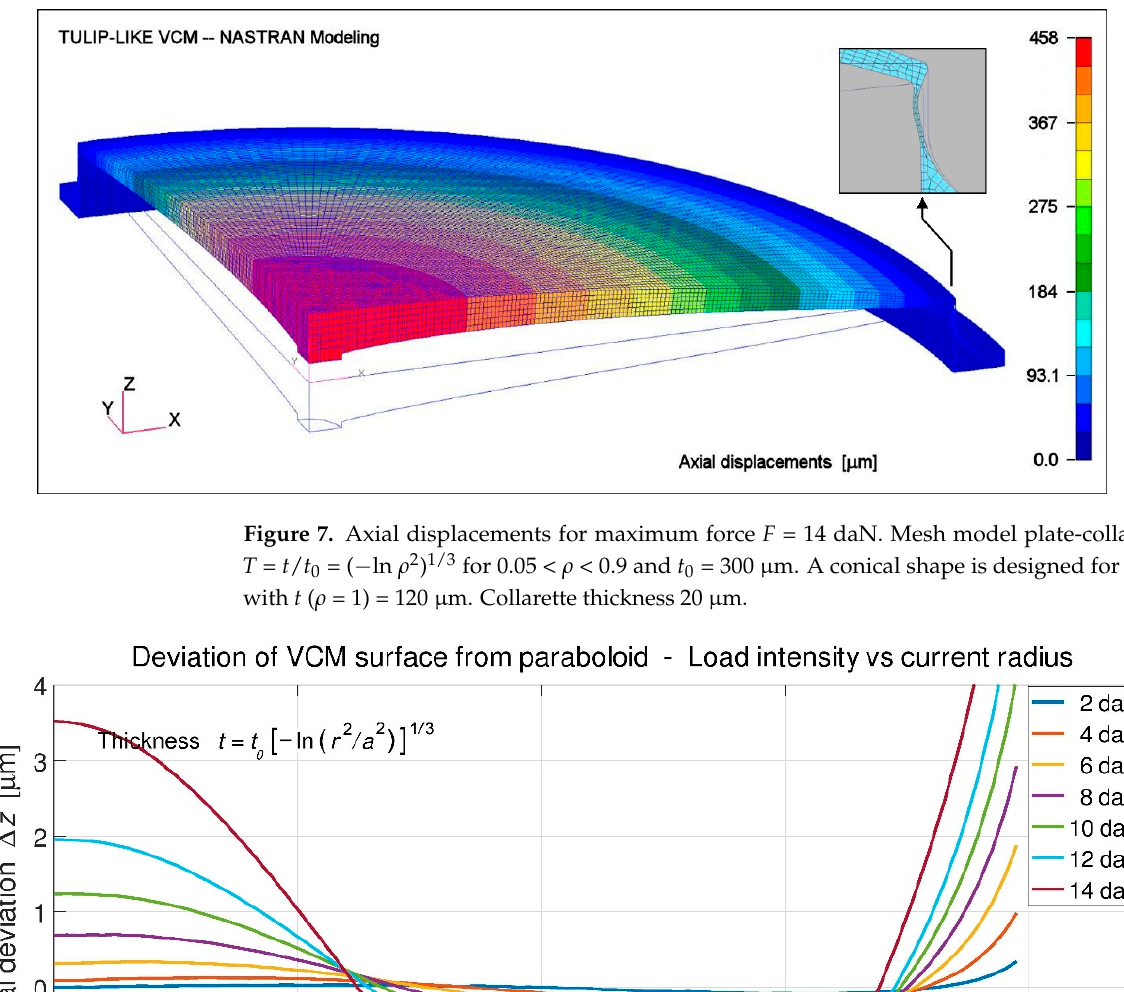
8 Figure 6. Least mean ‐ square flexural deviations with truncated radius at ρ = 0.05 and stud thickness t c = 618 μ m. Thickness T = t / t 0 = [ − ln( ρ 2 )] 1/3 for 0.05 < ρ < 0.95 and t 0 = 300 μ m. Conical for ρ > 0.95 with t (1) = 100 μ m. 4.2. Modeling of VCM with an Outer Cylinder Collarette and Rigid Ring For the practicable reasons of fabrication and avoiding interface problems, the tulip ‐ like form VCM plate shall be completed in a monolithic geometry using the im ‐ plementation of an outer radially thin cylinder—or collarette—linked to a rigid outer ring. The combination plate ‐ collarette ‐ ring is a one ‐ piece construction. Considering the flexural deviations obtained above that show the lack of rigidity of the plate con ‐ ical area, we slightly enlarge the conical area and somewhat increase its edge thick ‐ ness. The Nastran model is built with the same logic as the previous one without the collarette. The degree ‐ of ‐ freedom Z ‐ DOF boundary condition is now applied on the base of the rigid ring instead of on the mirror edge. Here, we also use the axisymmetry